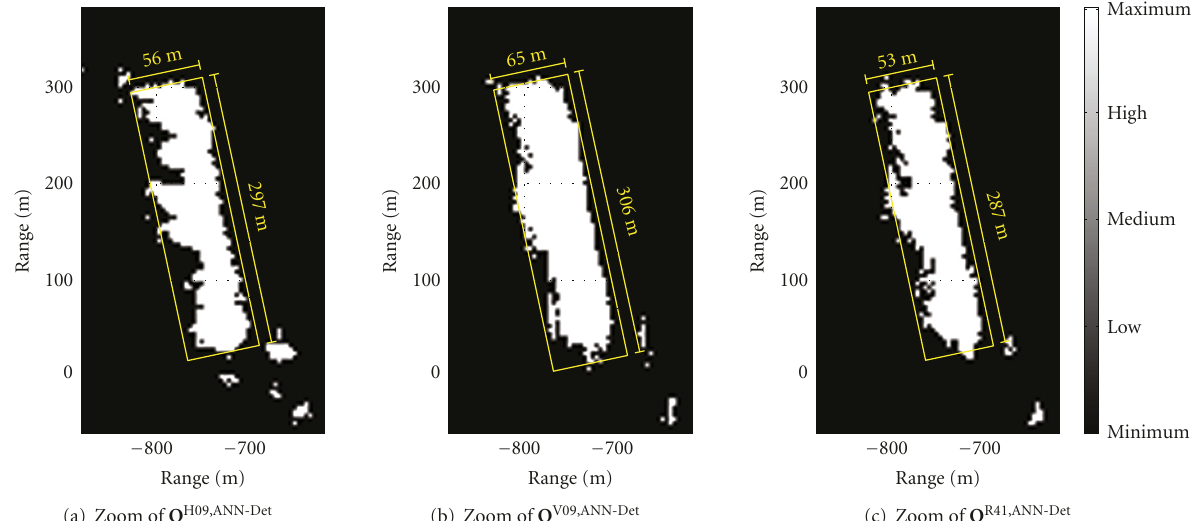
Figure 10: Zoom of the Images Processed by the ANN-based Detection System Using its Best H, V, and R Integration Modes.